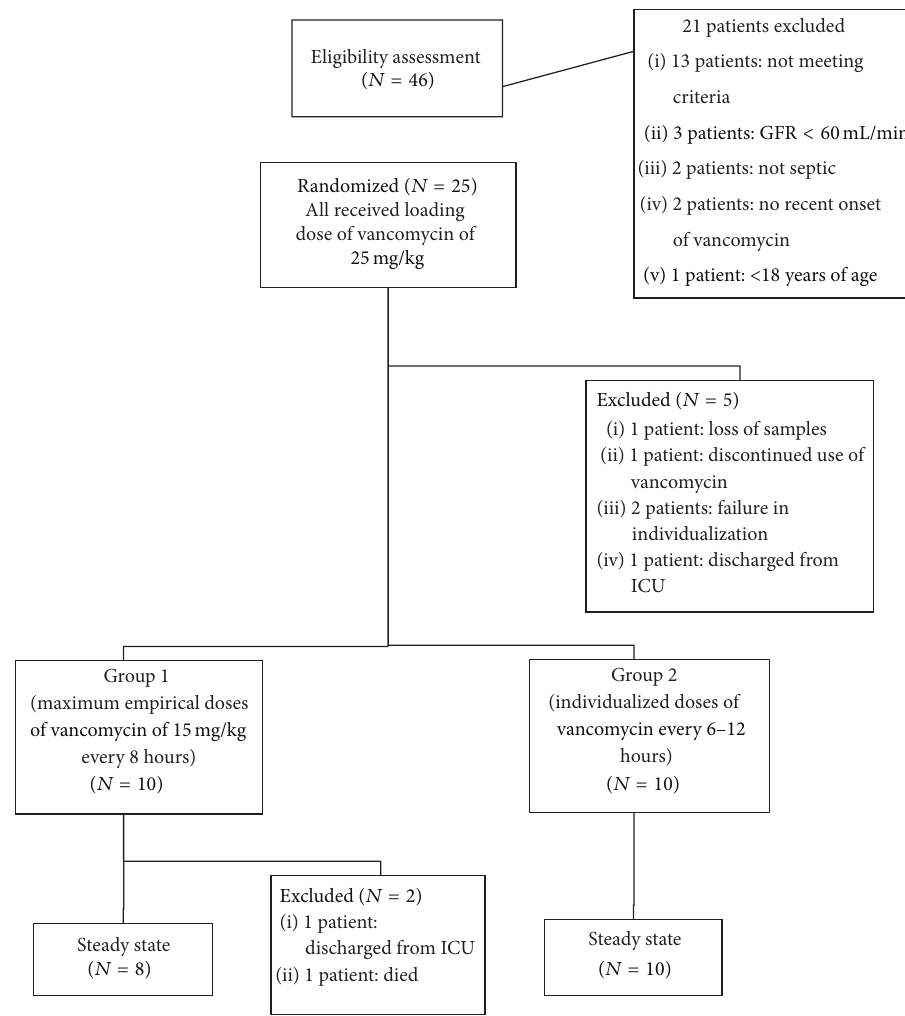
Figure 1: Structure of study